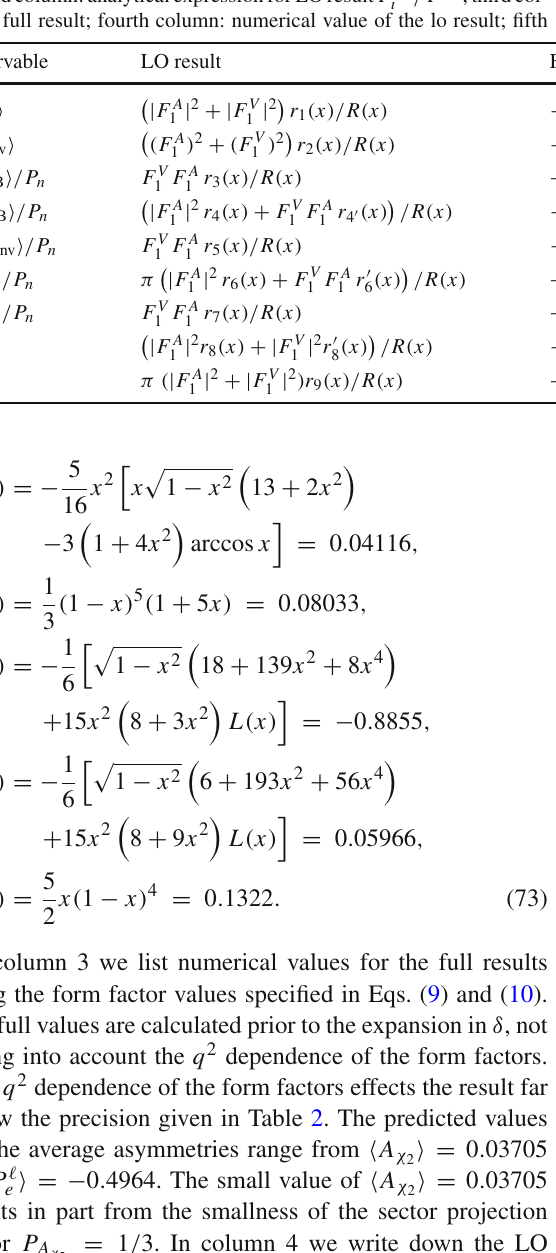
column: numerical value for the relative NLO correction; sixth column: ( 5 ) /(cid:8) ( 5 ) ;thirdcol- error propagation factor i